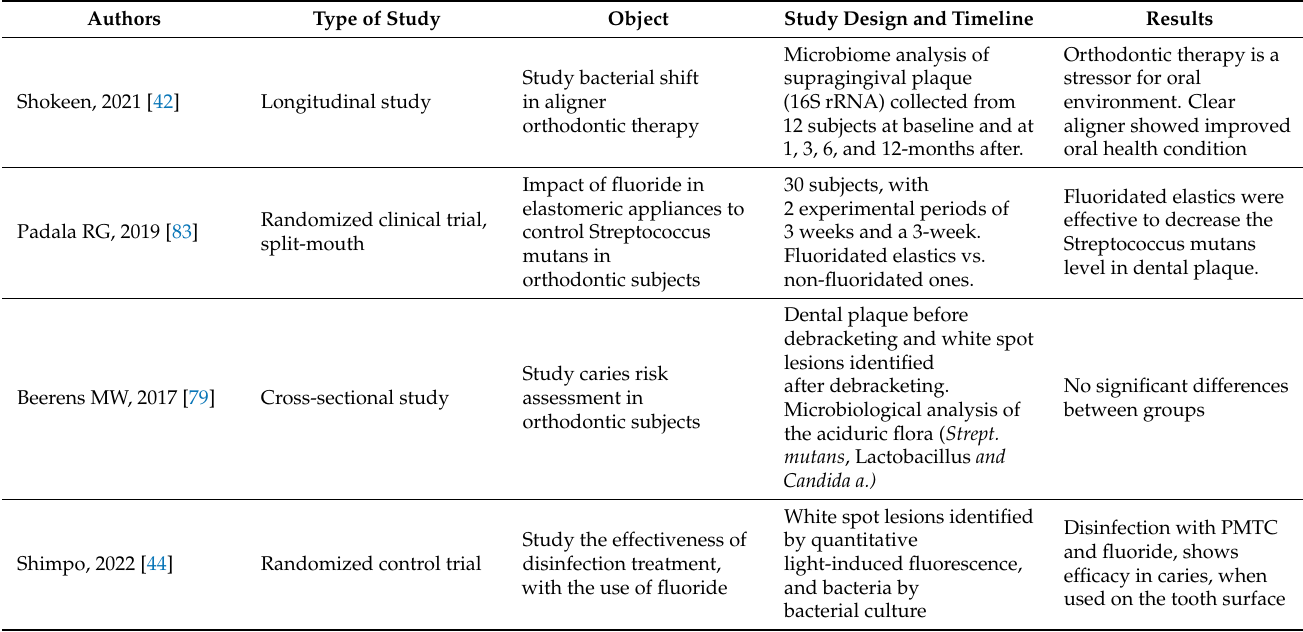
Table 2. Included studies that explored microbiota and